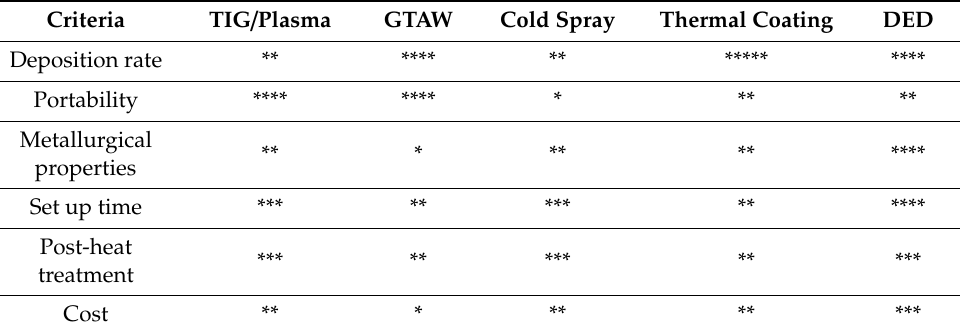
Table 5. Comparison between di ff erent repair methods for dies and molds [94–96].